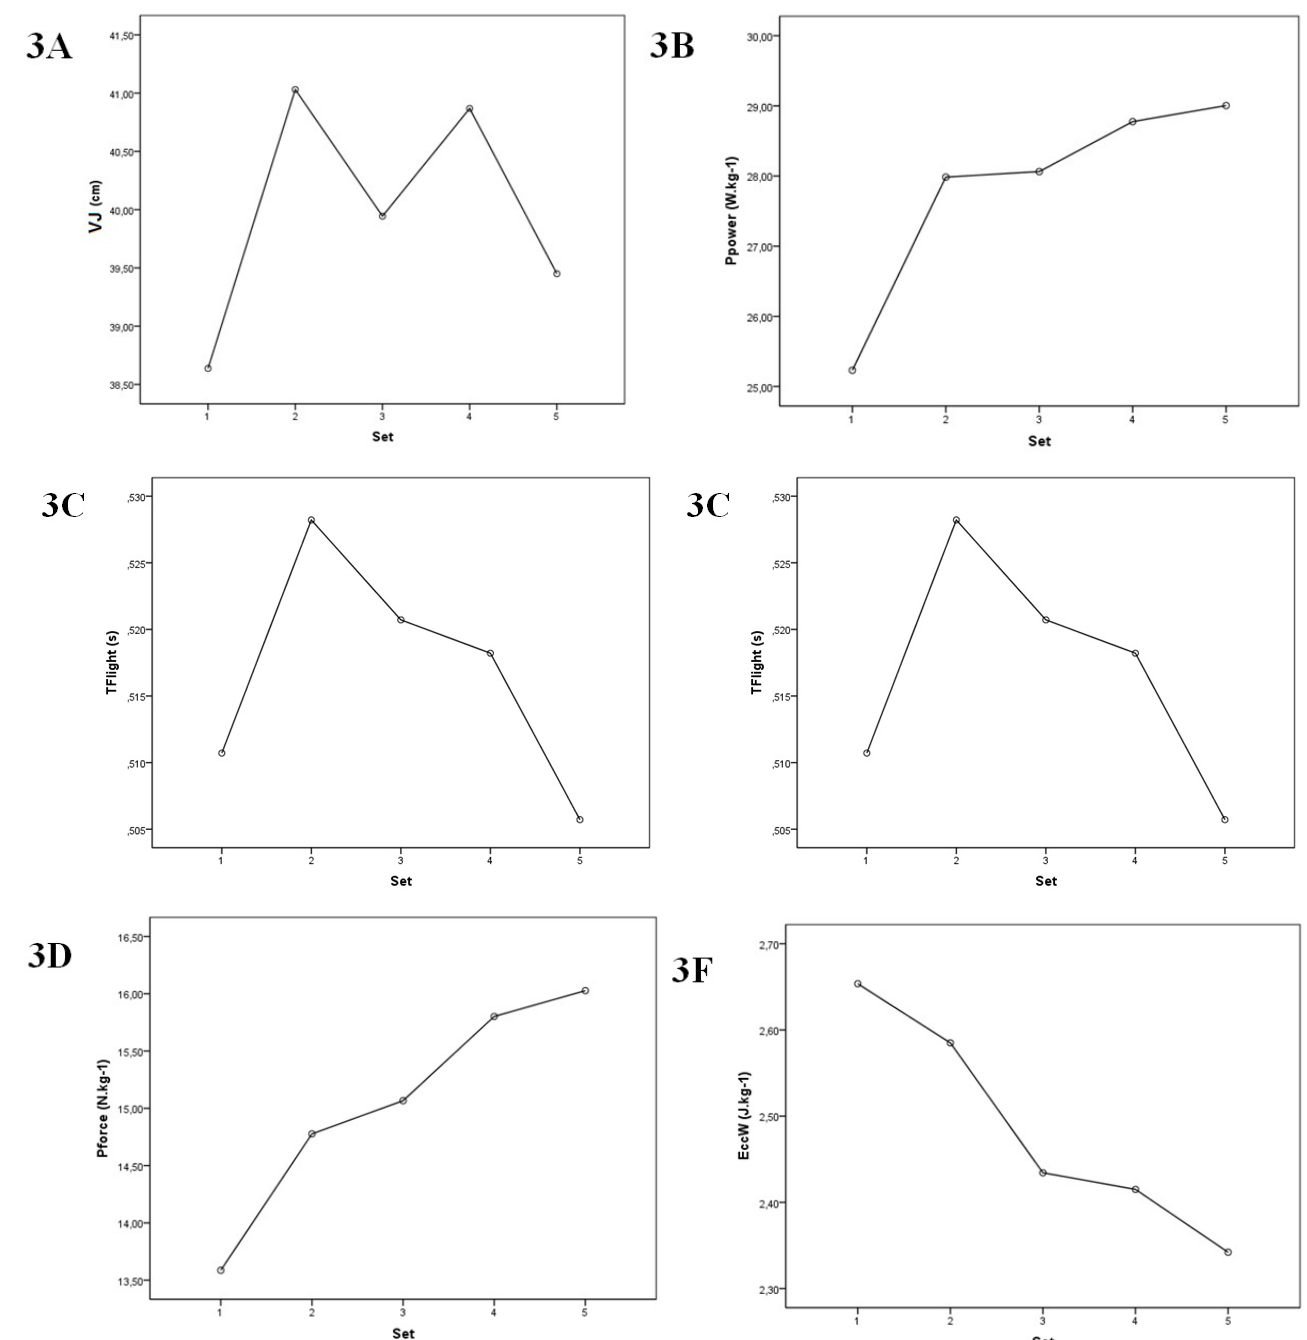
Figure 2. Profiles of results obtained in every measurements (rest, set1, set2, set3, and set4) for countermovement jump (VJ, 3A), peak power (Ppower, 3B), fligth time (Ftime, 3C), peak force (Pforce, 3D), peak velocity (Pvelocity, 3E), eccentric work (EccW, 3F), and concentric work (ConcW,